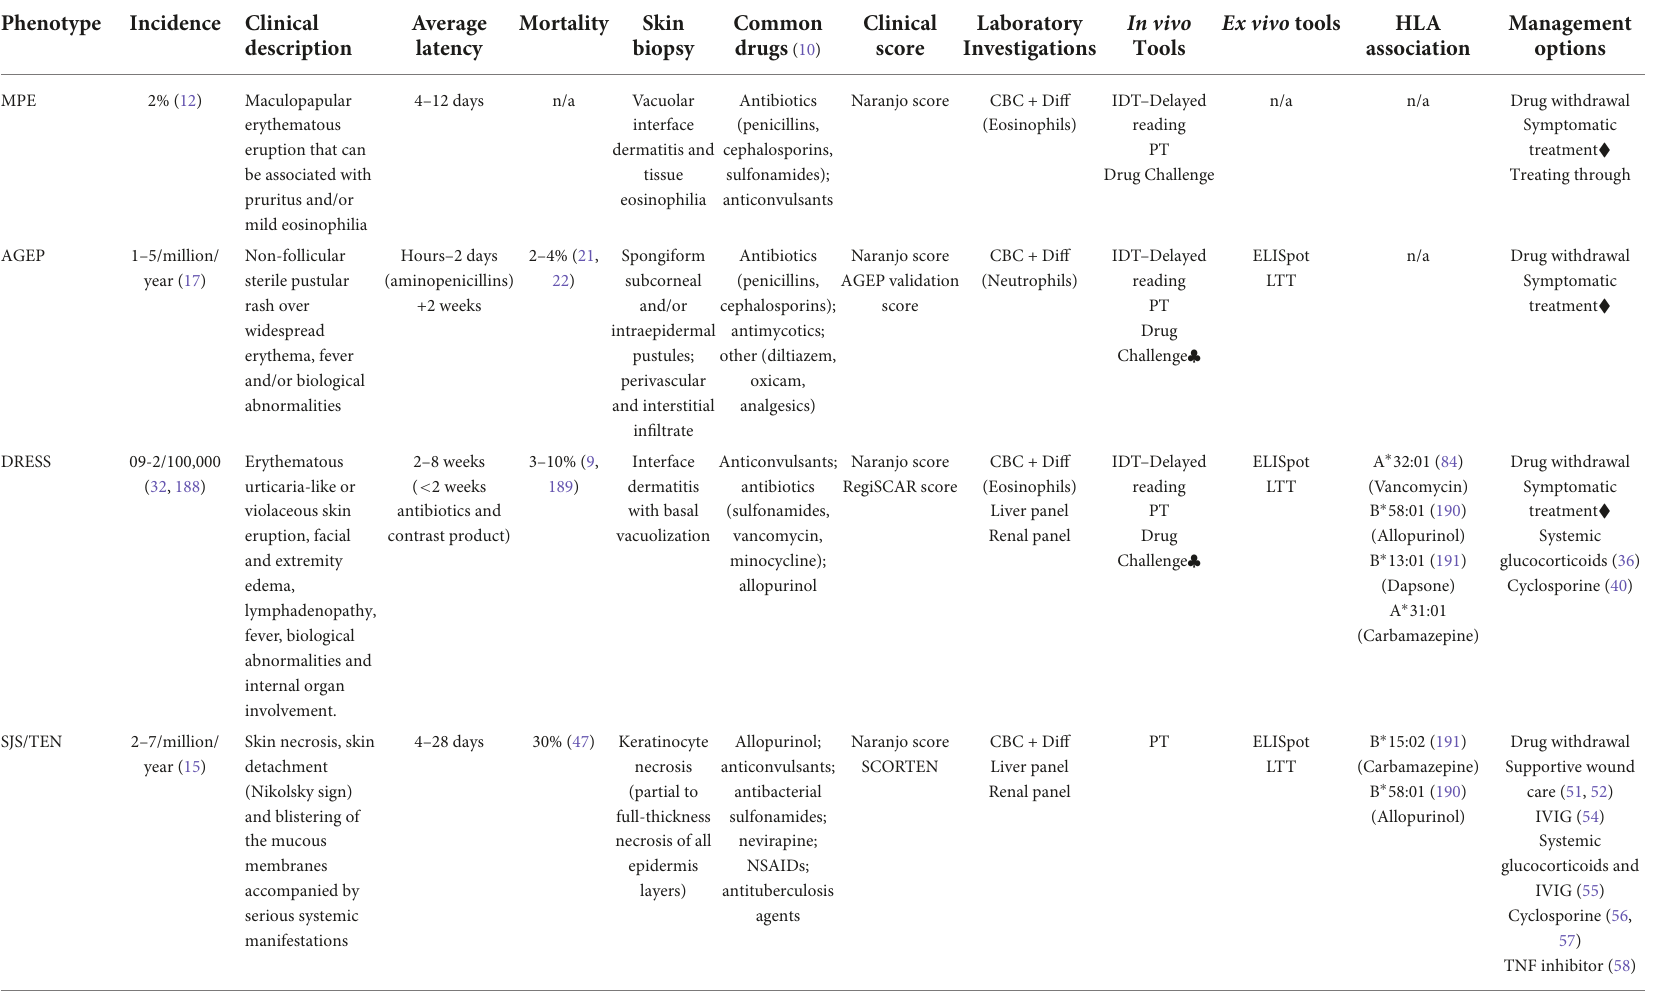
TABLE 1 Delayed drug related T-cell mediated hypersensitivity